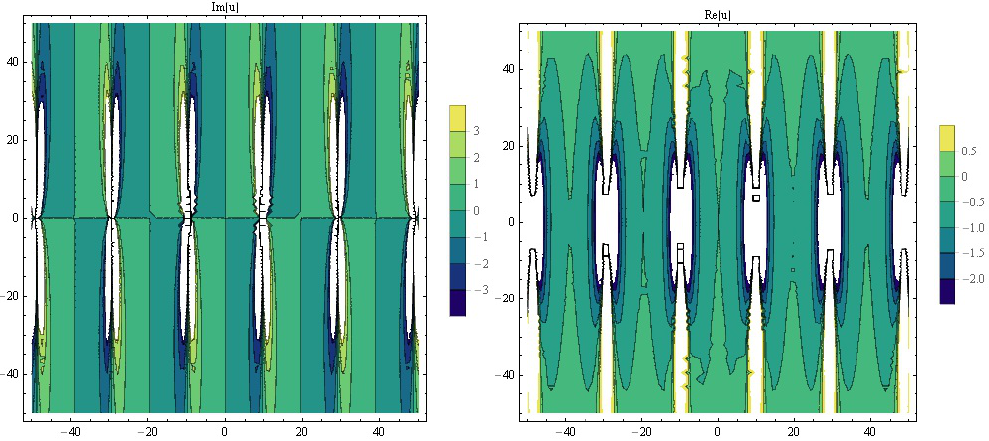
Figure 7. The contour simulations of u 6 for α 2 = 0.1, α 3 = 0.32, ε = 1, w = 0.012, A 2 = 0.5, c = 0.01, y = 0.05.